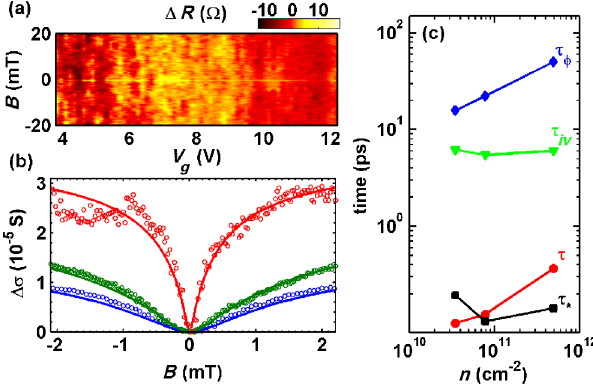
FIG. 4. (a) B and V dependence of the resistivity measured at g T ¼ 250 mK. (b) The circles represent magnetoconductivity curves Δ σ ð B Þ that have been ensemble averaged, by averaging ¼ − 7 (blue circles), traces in a range of gate voltages around V g 7 (green circles), and 30 V (red circles), to suppress sample- specific fluctuations. The continuous lines are fit to the theory of weak localization in graphene. (c) Characteristic times extracted at 250 mK for different values of carrier density, either from the fit of weak-localization curves ( τ ϕ , τ , and τ (cid:1) ) or from iv the conductivity ( τ ). The elastic scattering time τ is always at least 1 order of magnitude smaller than the intervalley scattering time τ iv